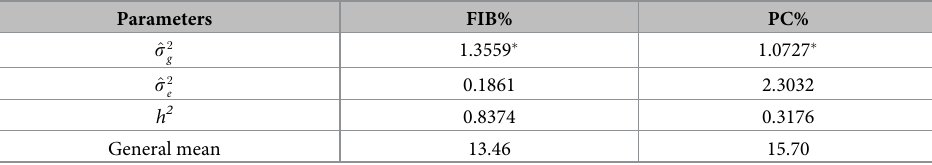
Table 1. Genetic and environmental parameter estimates of the 385 sugarcane clones evaluated.